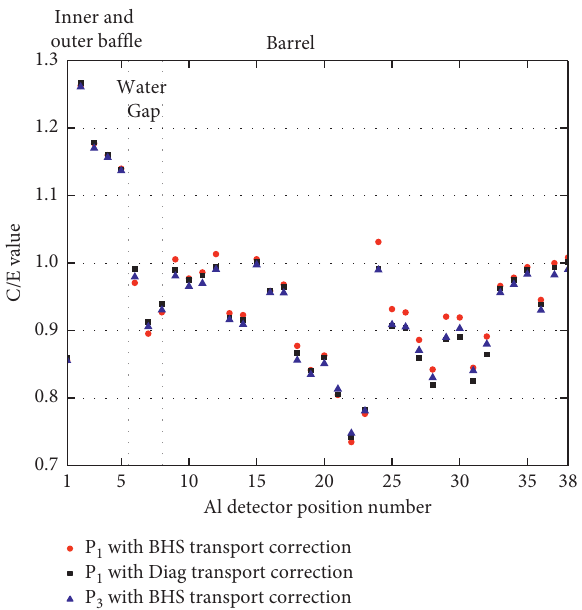
Figure 25: Comparison of P 1 transport correction with P 3 results of the 27 Al(n, α ) 24 Na